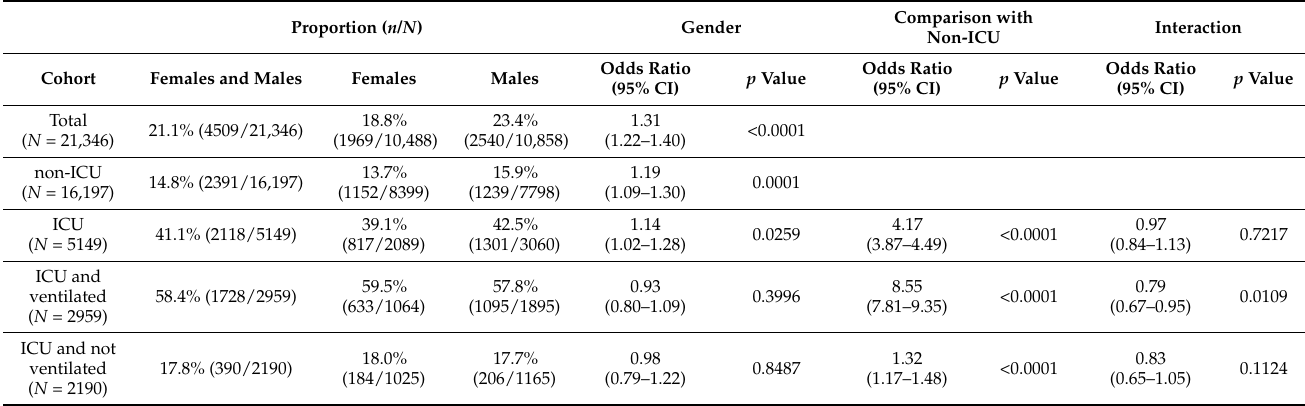
Table 3. Comparison of In-Hospital Mortality.